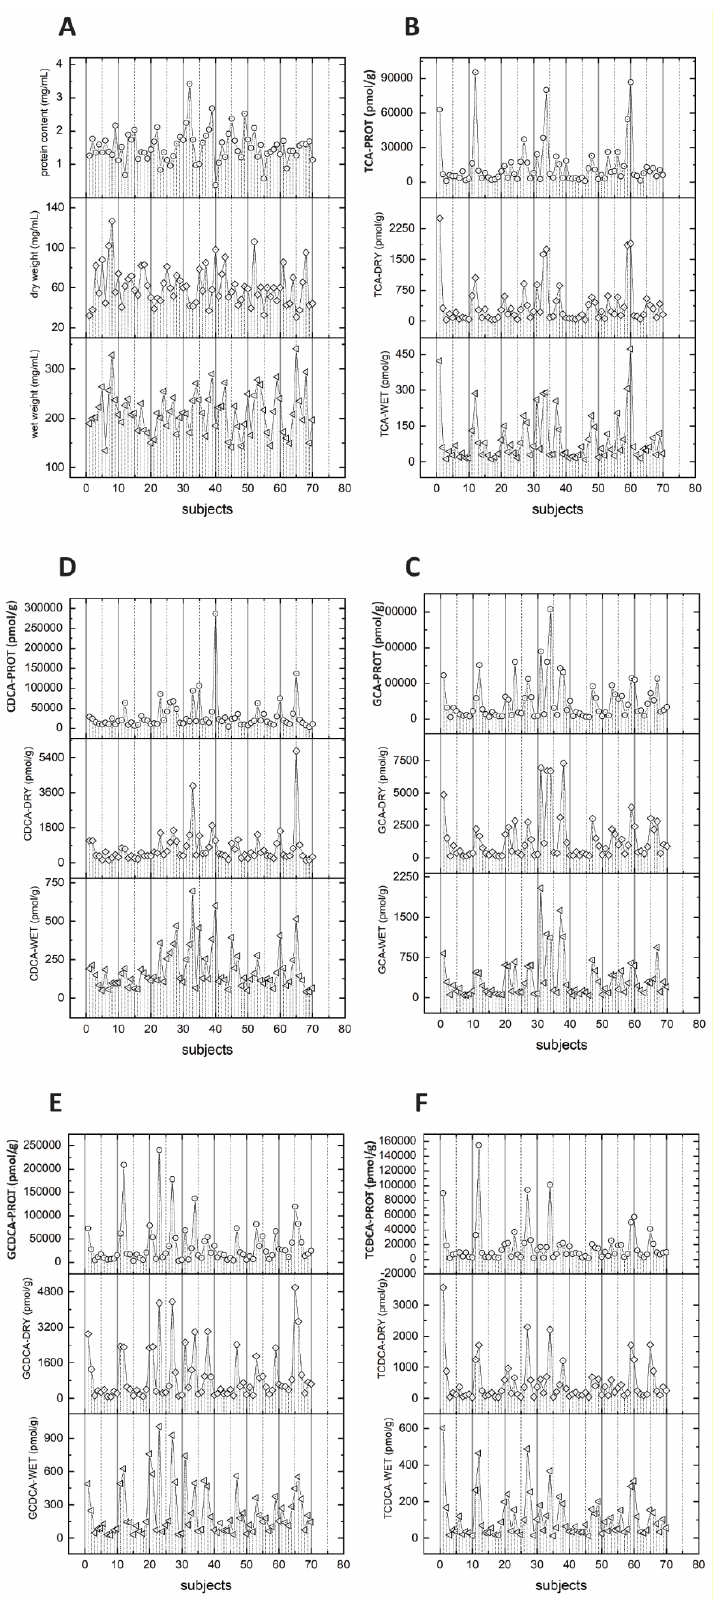
Figure 3. ( A ) Individual wet weight, dry weight, and protein content of 70 human feces samples from 42 volunteers. Distribution of measured concentration of five bile acids, TCA ( B ), GCA ( C ), CDCA ( D ), GCDCA ( E ), and TCDCA ( F ).